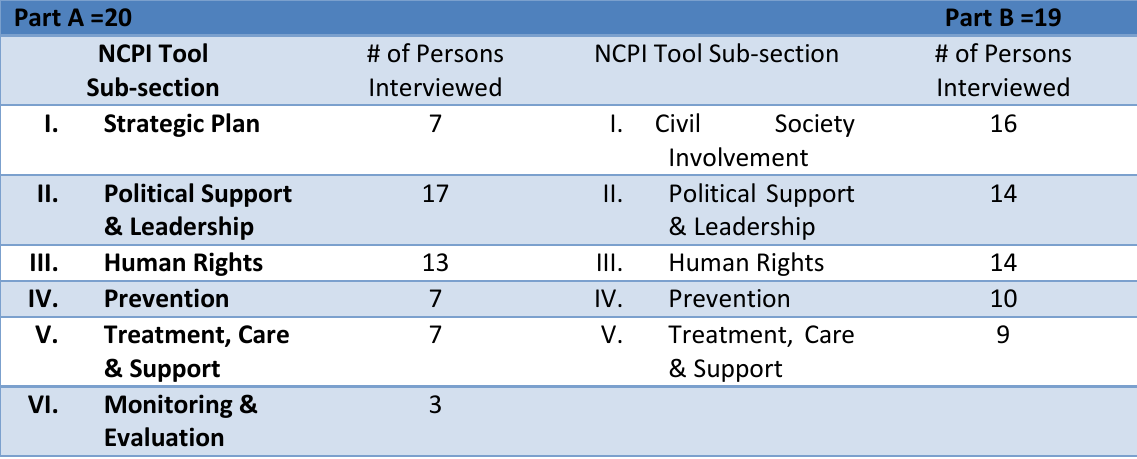
Table 6: Number of Person who completed each Sub-section of Part A and B of the NCPI in